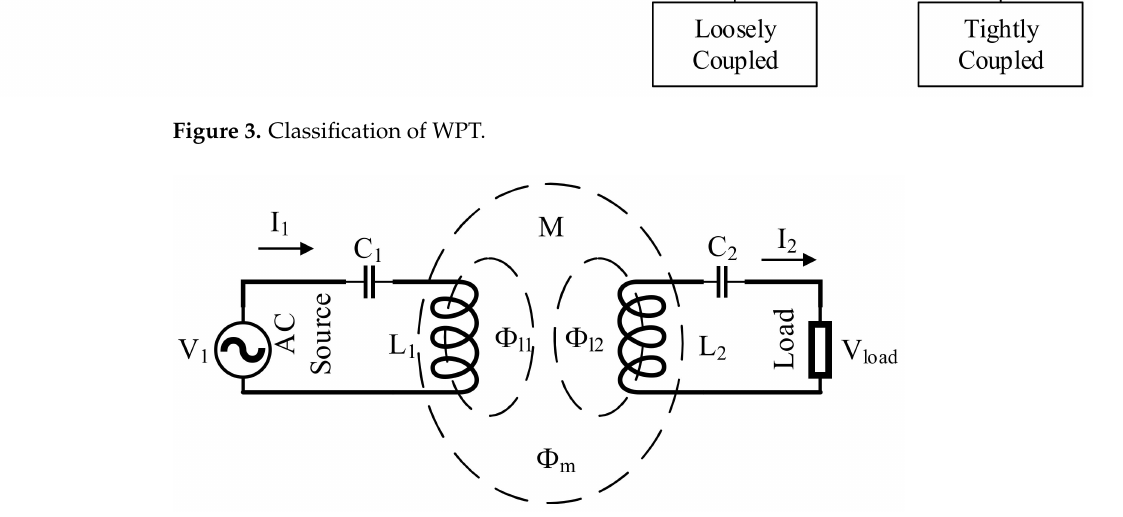
Figure 4. Fundamental structure of an IPT system. The block diagram showing all components of an IPT system is given in Figure 5.